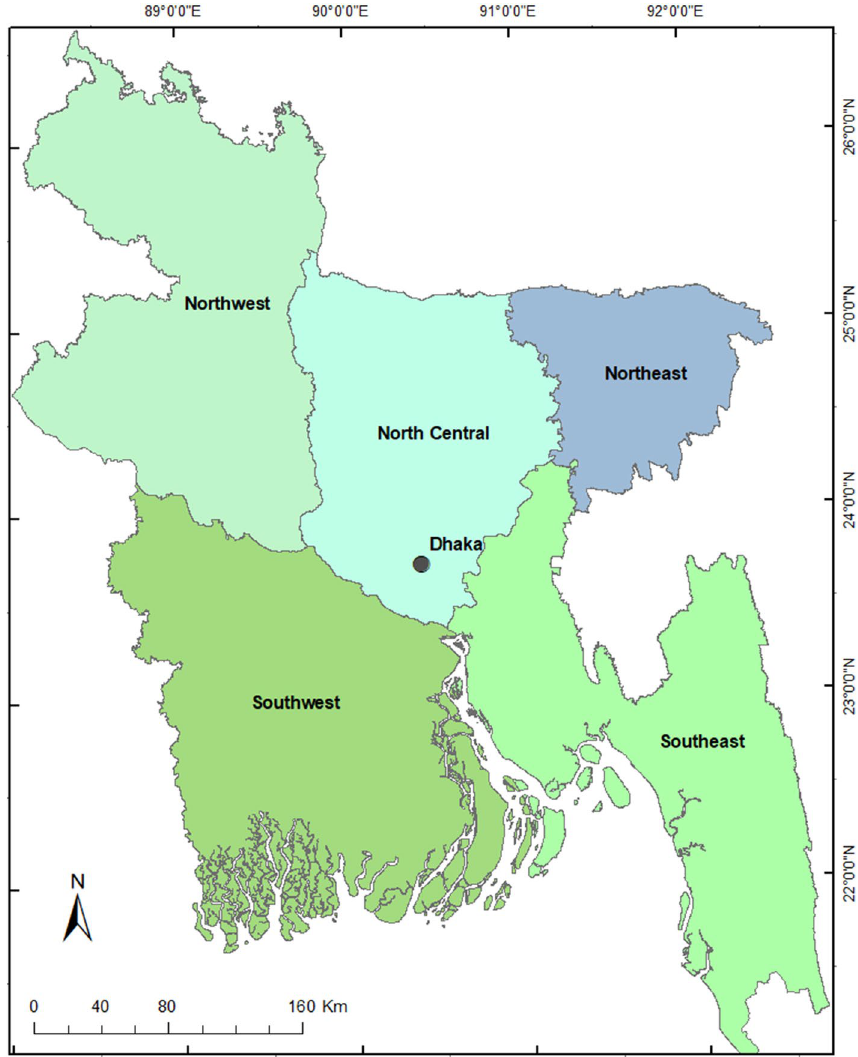
Figure 1. Outline map of Bangladesh with the five regions examined in this paper. The Northwest region comprises the Rangpur and Rajshahi divisions of Bangaldesh; North Central, the Mymensingh division and Dhaka division north of the Padma River; Northeast, Sylhet division; Southwest, Khulna and Barisal divisions and Dhaka division south of the Padma River; Southeast: Chittagong